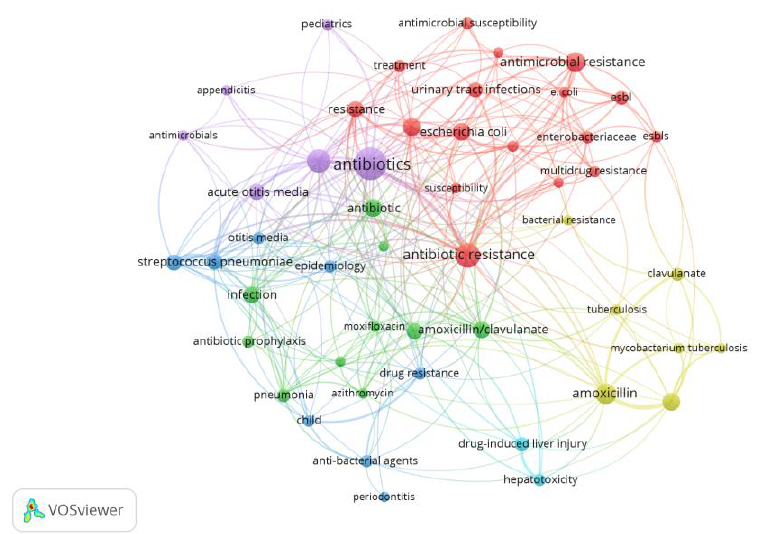
Figure 4. Research topic map for publications related to clavulanic acid and clavulanate studies. Table 1. Top 10 author keywords of CA and clavulanate studies. Rank Keywords